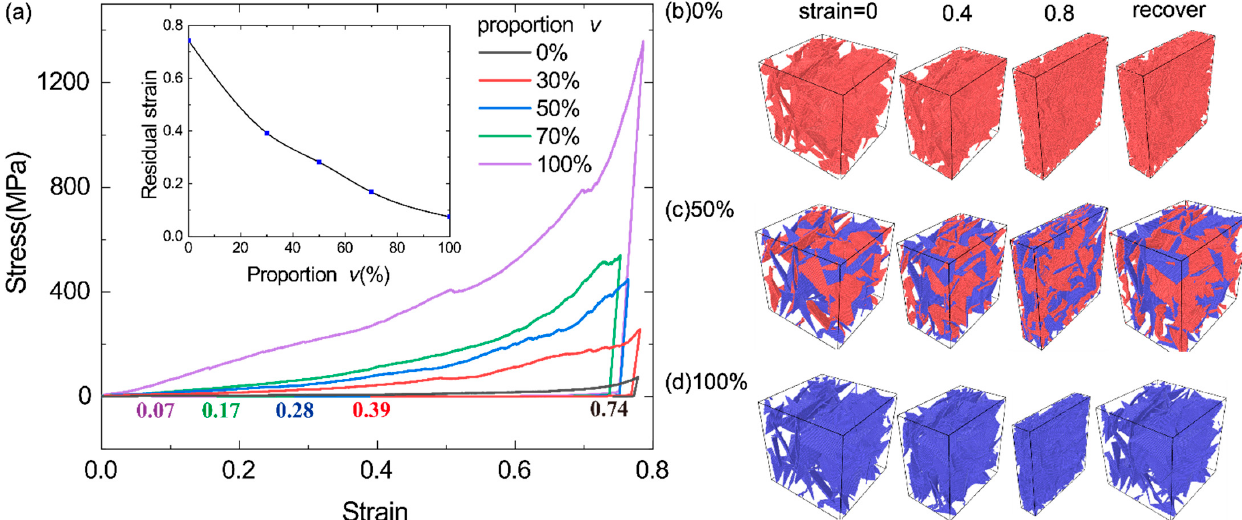
Figure 6. The effect of the proportion of 8-layer sheets on the elastic recovery of GrFs. ( a ) The stress-strain curves of GrFs with v = 0, 30%, 50%, 70% and 100% in the compression–uncompression process. Inset: the residual strain as a function of v ; ( b – d ) Four typical snapshots of the GrFs with v = 0, 50% and 100% at the compressive strain of 0, 0.4 and 0.8 and after